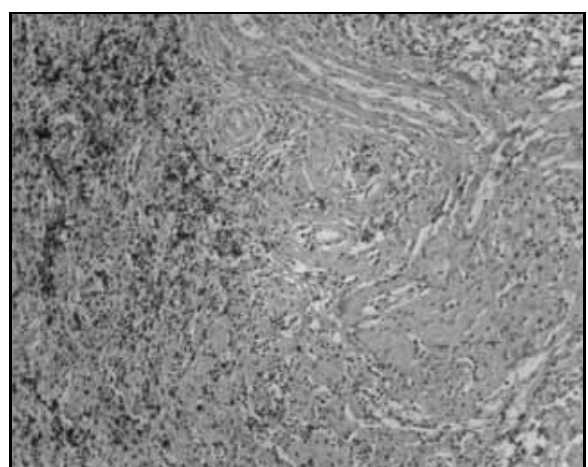
Figure 5 – Inflammatory cells showed positive immunoexpression for CD20, streptavidin-biotin